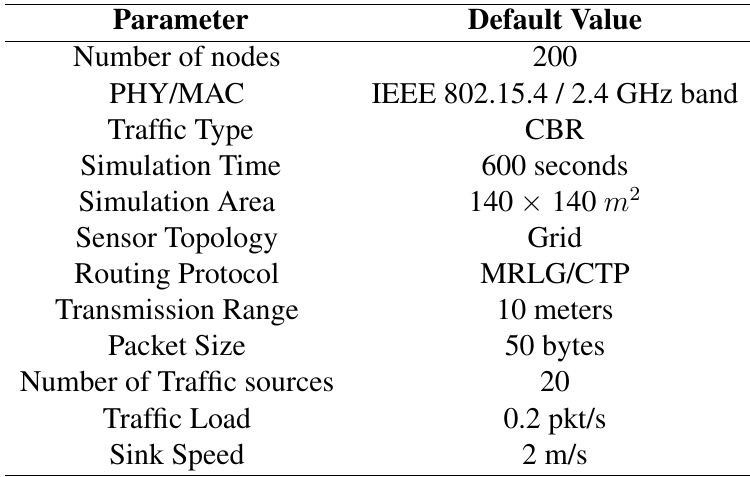
Table 2. Default simulation